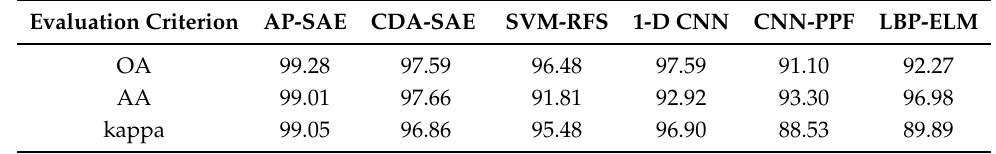
Table 6. Performance comparion of different thresholds for pavia university.